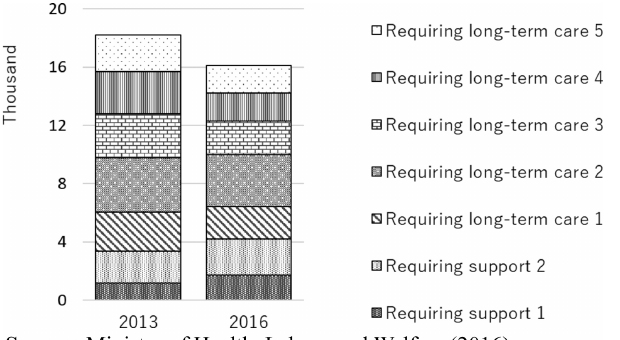
Figure 4. The number of people certified by the public Long-term Care insurance system for cerebrovascular disease, with their certification